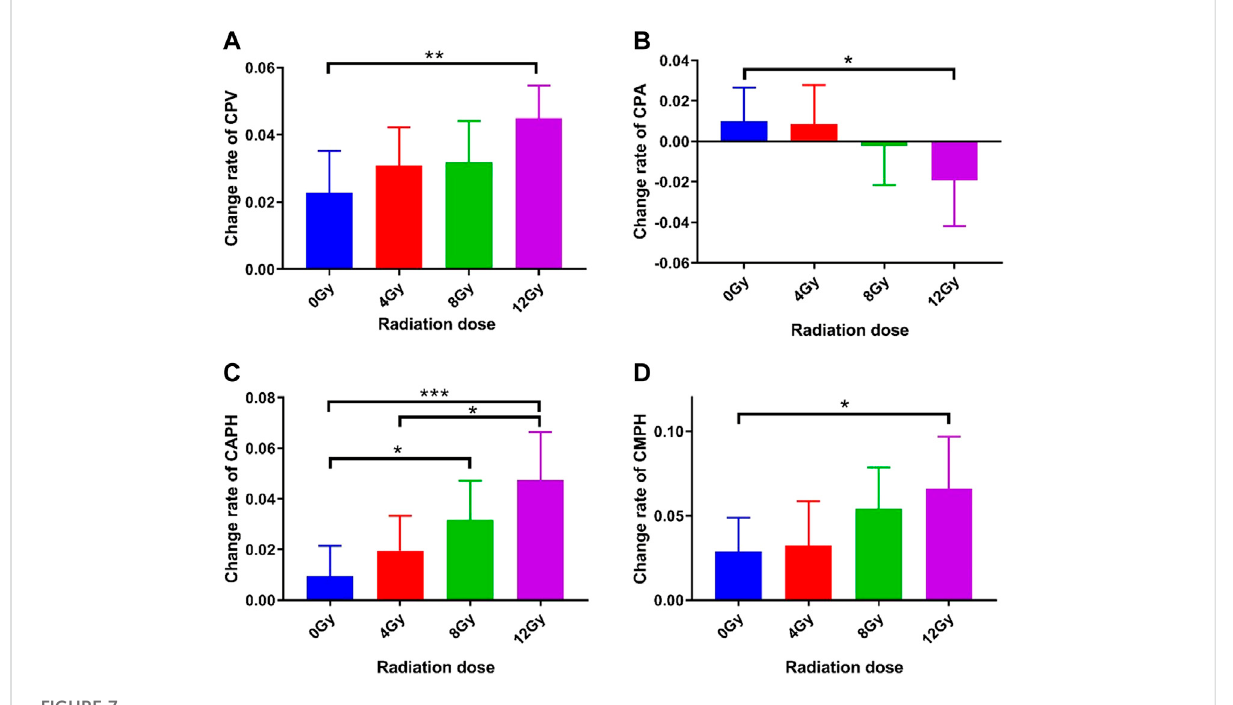
FIGURE 7 The change rates in CPV, CPA, CAPH and CMPH of each